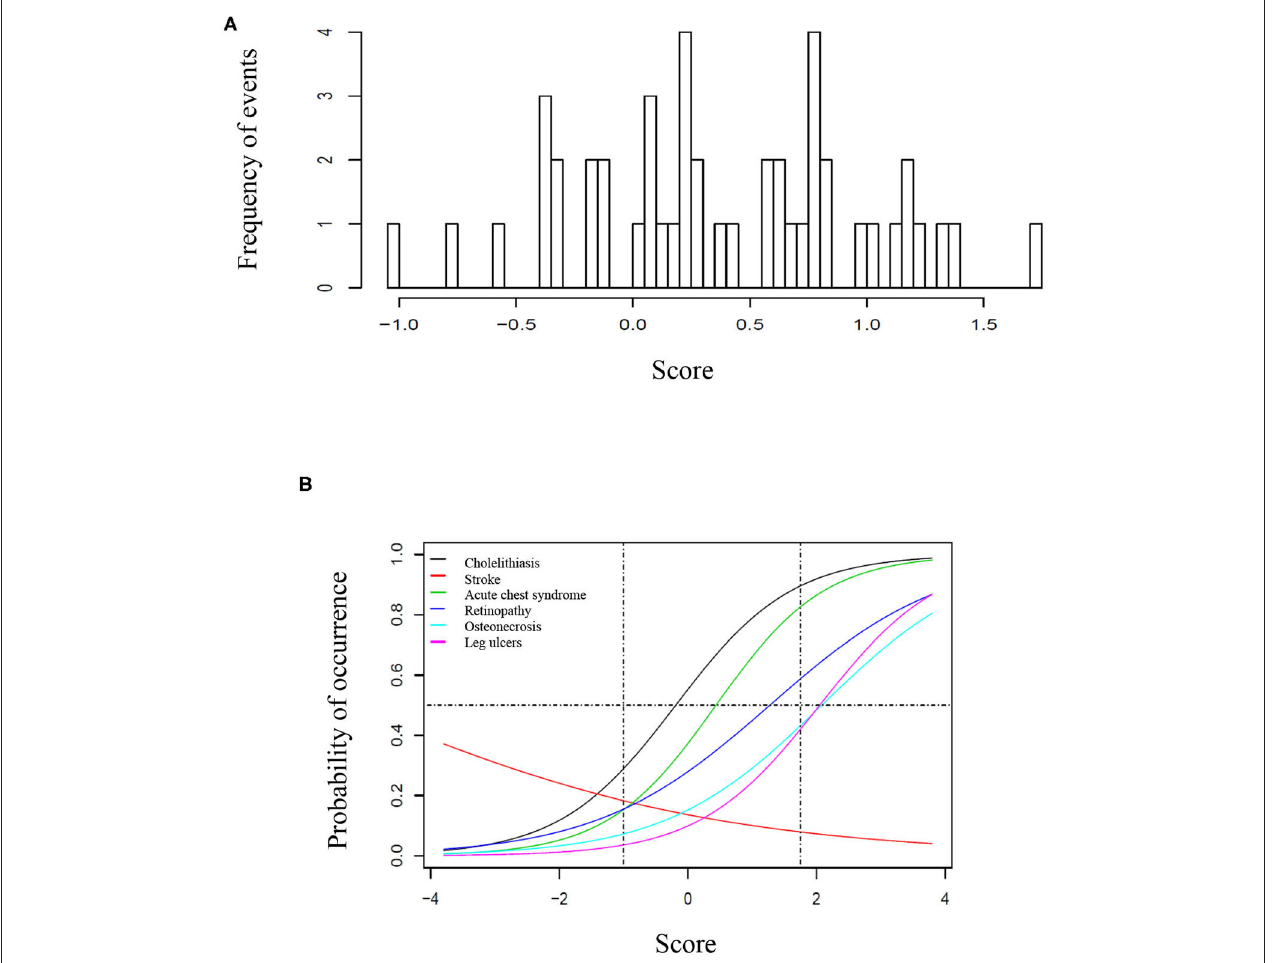
FIGURE 1 | Score of clinical complications in the study cohort. (A) Histogram representing the score of clinical complication calculated for each patient based on the item-response theory (ITR). (B) Characteristic curves for each clinical complication, based on the IRT score. (A) Represents the score based on the distribution of complication for each patient, ranging from − 1 to ∼ 1, 8. In (B) , the curves are shown from − 4 to 4 to better illustrate the trend of each curve, however the vertical traced lines indicate the interval where patients are located. In this cohort, the probability of occurrence was higher for cholelithiasis, followed by acute chest syndrome, retinopathy, osteonecrosis, and leg ulcers. The horizontal line represents 50% of probability. For instance, a patient with 50% probability of having retinopathy had > 50% probability of presenting cholelithiasis and acute chest syndrome, but < 50% for osteonecrosis and leg ulcers. Patients who presented stroke had less probability of presenting all other clinical